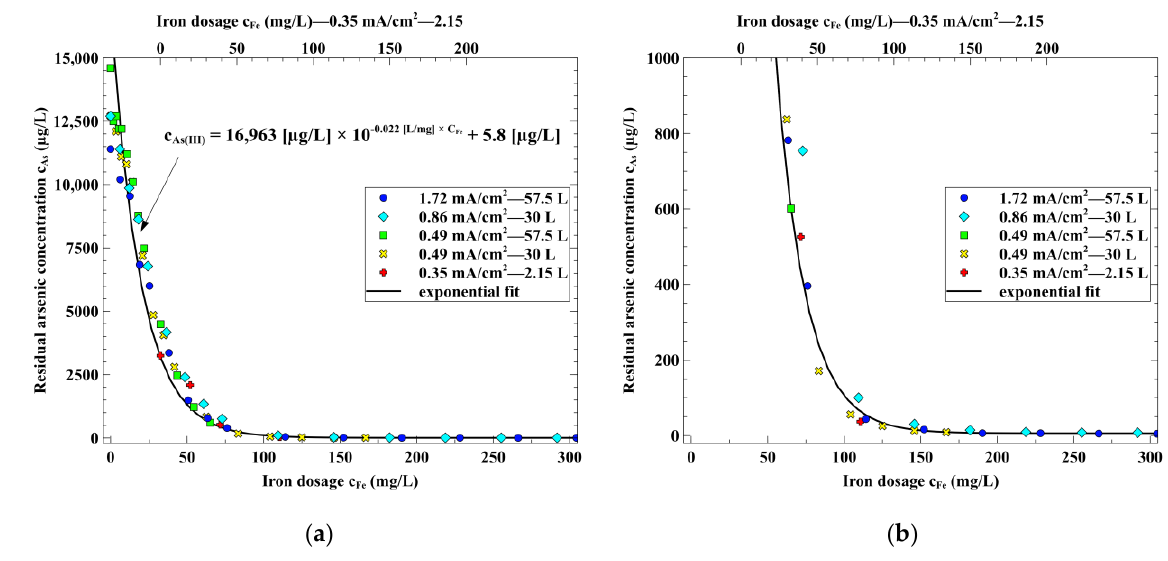
Figure 4. Residual arsenic concentrations as a function of iron added. ( a ) Exponentially fitted to all samples with high initial concentration . χ 2red = 29, fitted with Veusz 3.2 for minimal χ 2 . ( b ) Zoomed in for residual arsenic concentrations < 1000 µg/L. Experiment 0.35 mA/cm 2 — 2.15 L is referenced to second axis.